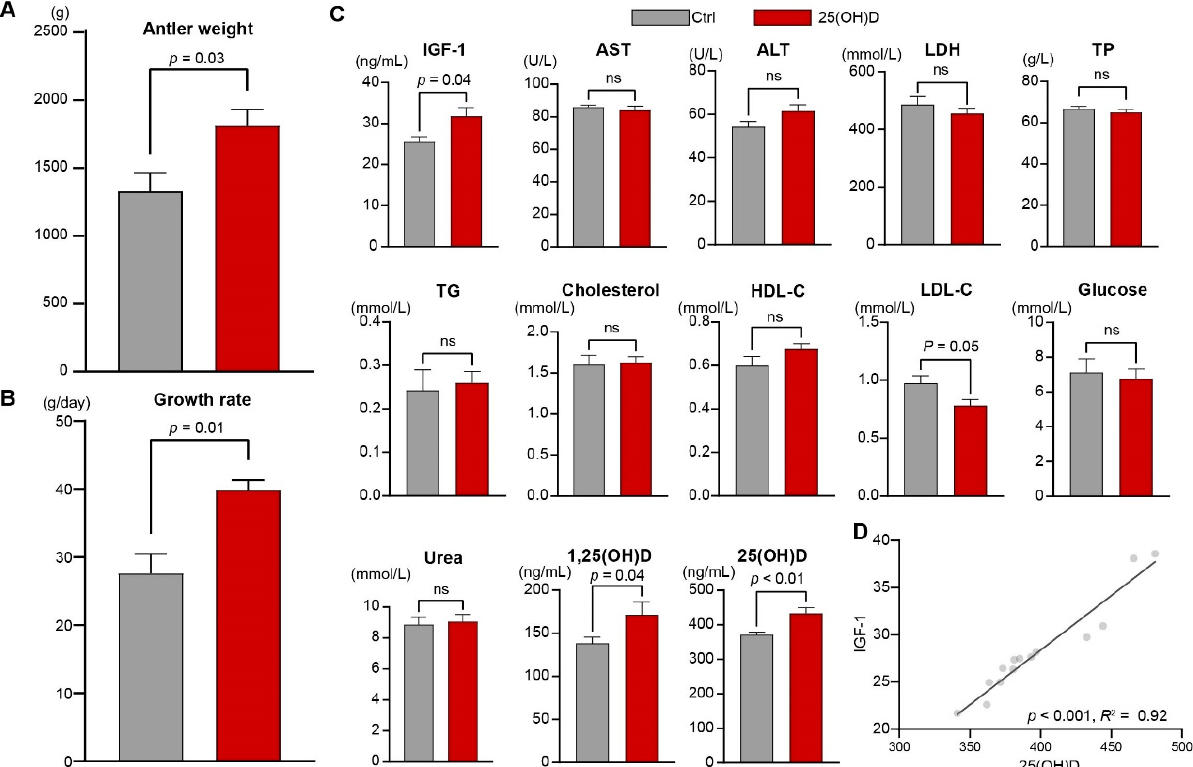
Figure 1. Changes in antler production performances and host metabolism with 25(OH)D supplementation. Comparison of the ( A ) antler weight, ( B ) growth rate of the antler, and ( C ) plasma metabolites between the Ctrl and 25(OH)D groups. ns means no significant differences. p value indicates the statistical significance of the differences, which were determined using WRS test based on the Benjamini–Hochberg correction. ( D ) The correlation between plasma 25(OH)D and IGF-1 concentrations. p value indicates the statistical significance of the differences, which were determined using liner regression analysis. The R 2 value indicates the coefficient of determination. IGF-1: Insulin Growth Factor-1, AST: Aminotransferase, ALT: Alanine Aminotransferase, LDH: Lactate Dehydrogenase, TP: Total Protein, TG: Triglyceride, HDL-C: High-Density Lipoprotein Cholesterol, LDL-C: Low-Density Lipoprotein Cholesterol, 1,25(OH)D: 1,25-Dihydroxyvitamin D, 25(OH)D: 25-Hy- droxyvitamin D.